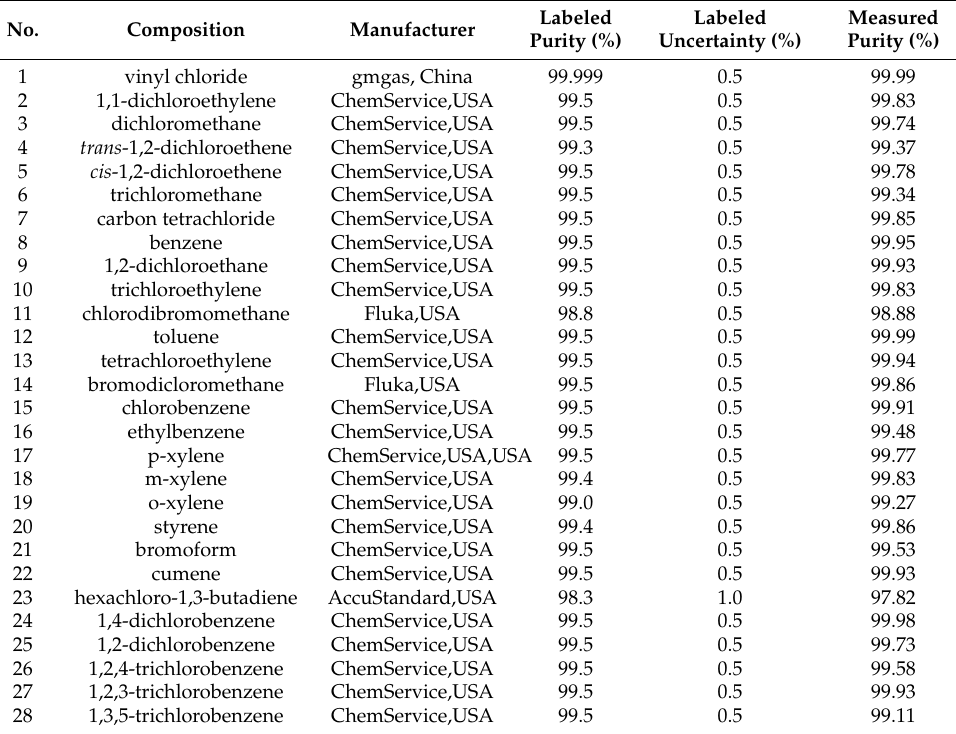
Table 6. Purities of 28 commercial VOC